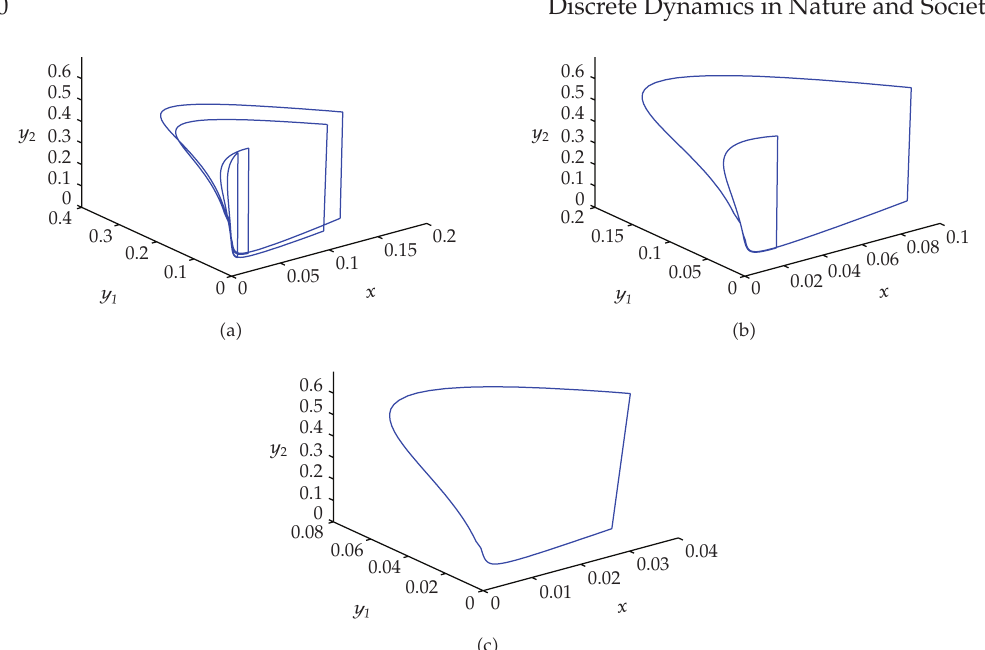
Figure 8: Period halving cascade: (cid:2) a (cid:3) phase portrait of T -periodic solution for q (cid:6) 0 . 49; (cid:2) b (cid:3) phase portrait of 2 T -periodic solution for q (cid:6) 0 . 52; (cid:2) c (cid:3) phase portrait of T -periodic solution for q (cid:6) 0 . 6.